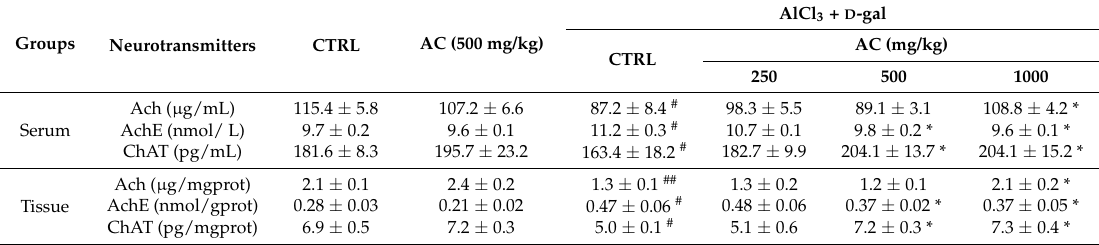
Table 1. AC regulated the levels of Ach, ChAT and AchE in the serum and brain.